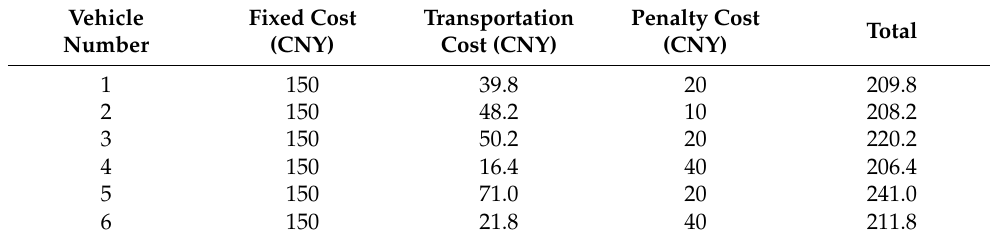
Table 13. Optimize the pre-delivery vehicle cost table.